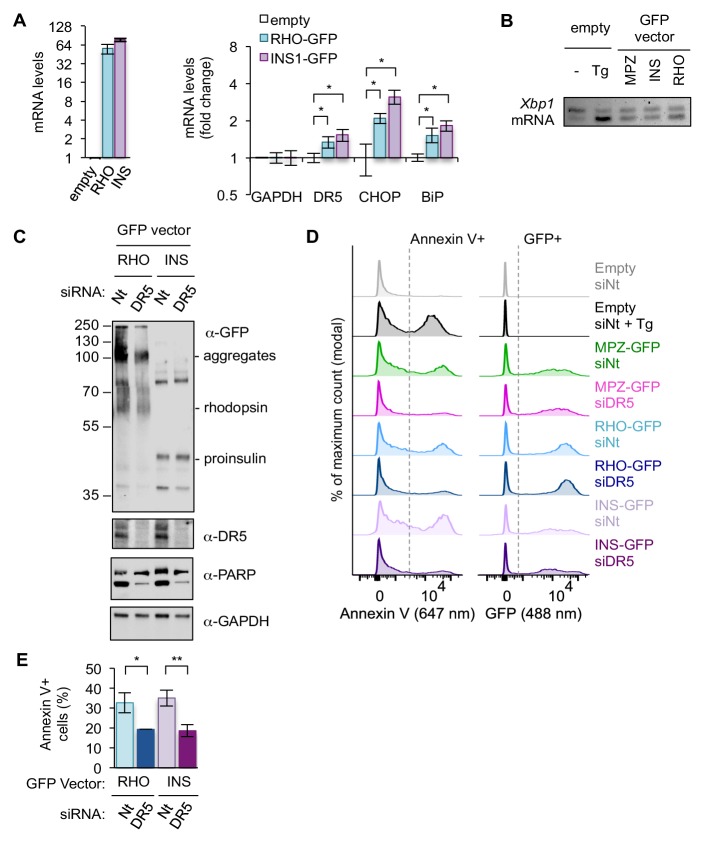
Sustained overexpression of other ER-trafficked proteins induce UPR-mediated apoptosis in a DR5-dependent manner.(A) qPCR for reverse-transcribed transcripts harvested from HCT116 cells transfected with 1.0 μg of GFP-tagged rhodopsin (RHO), proinsulin (INS), or 1.0 μg of the empty vector for 24 hr (n = 2 biological replicates, each with three technical replicates; error bars = SD; * denotes p<0.05). (B) RT-PCR for unspliced and spliced forms of Xbp1 mRNA isolated from HCT116 cells transfected for 24 hr with 1 μg of empty vector -/+ 100 nM Tg for 2 hr, MPZ-GFP, INS-GFP, or RHO-GFP. (C) Western blot of HCT116 cells transfected with siRNA against a non-targeting (Nt) control or DR5 (48 hr) followed by 1.0 μg RHO-GFP or INS-GFP (24 hr). (D) Representative flow cytometry histograms of HCT116 cells transfected with the listed siRNA and vector and stained with annexin V-AlexaFluor647. Y-axis has been scaled so that the mode = 100%. Dotted lines represent gating to distinguish staining-positive cells. Left: Histograms of fluorescence at 647 nm to measure annexin V staining. Right: Histograms of fluorescence at 488 nm to compare level and distribution of GFP-tagged protein expression. To note, GFP expression profiles for the same construct are similar between different siRNA transfected samples. (E) Average percent of annexin V-positive cells for HCT116 cells transfected with siRNA and GFP-tagged rhodopsin/proinsulin (n = 3 biological replicates, error bars = SEM, * indicates p=0.011, ** indicates p=0.005 from unpaired t-test with equal SD). Gating for annexin V-positive staining is shown in Figure 1—figure supplement 4D.